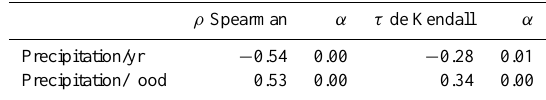
Table 5. Correlations between precipitation and floods.